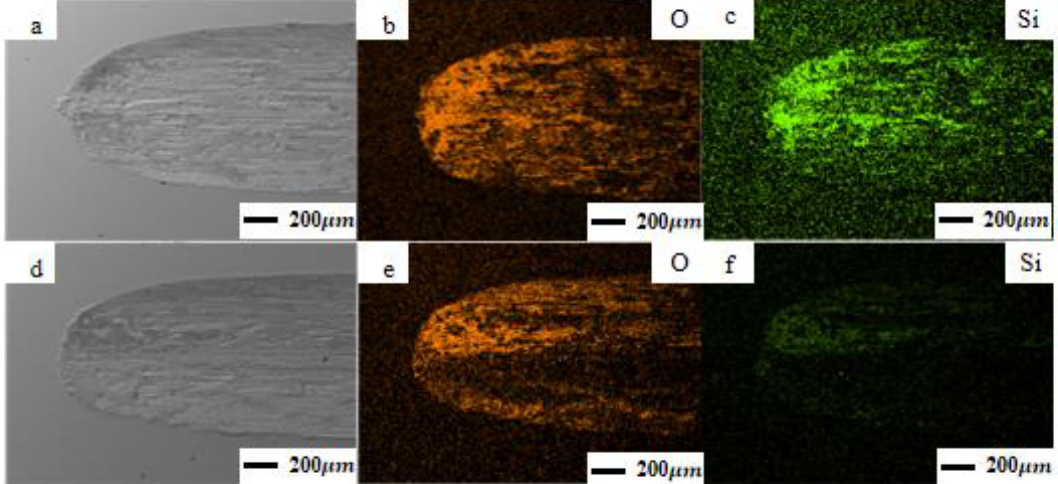
Figure 15. Dry Friction Surface Scanning Distribution of O and Si Elements on Inconel 625 Wear Surface ( a,b,c ) base material; ( d,e,f ) 720 mA.